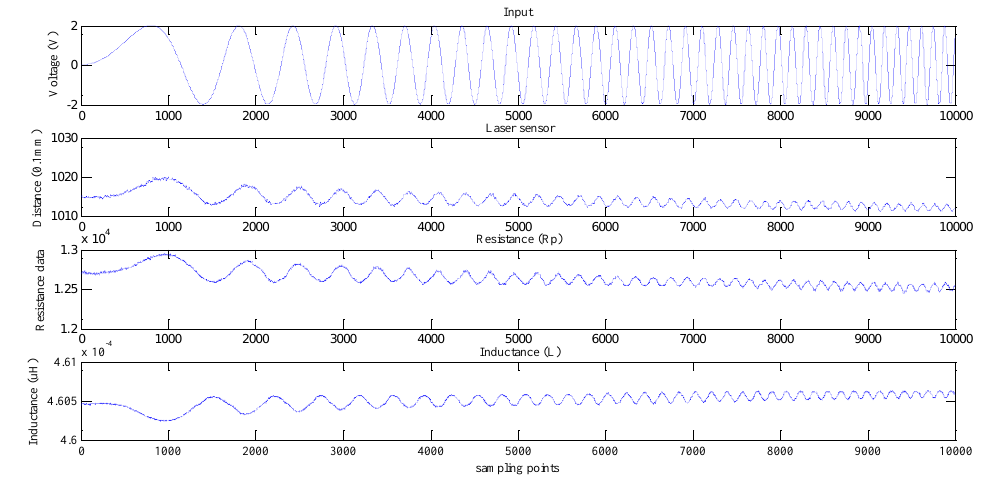
Figure 6. Input and measured outputs of laser and inductive